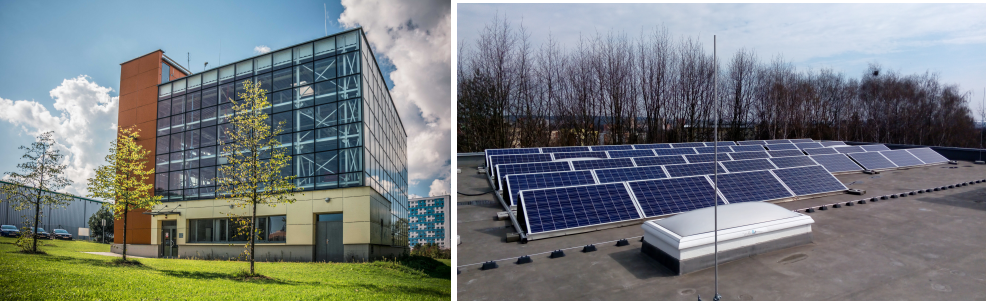
Figure 1. A view of APS; APS skeleton.